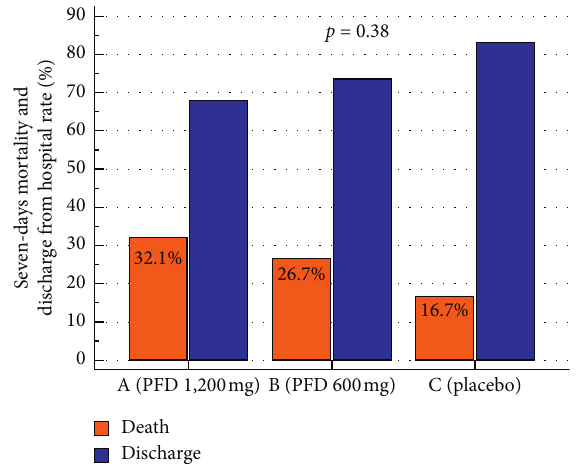
Figure 3: Mortality and discharge from hospital rate according to study